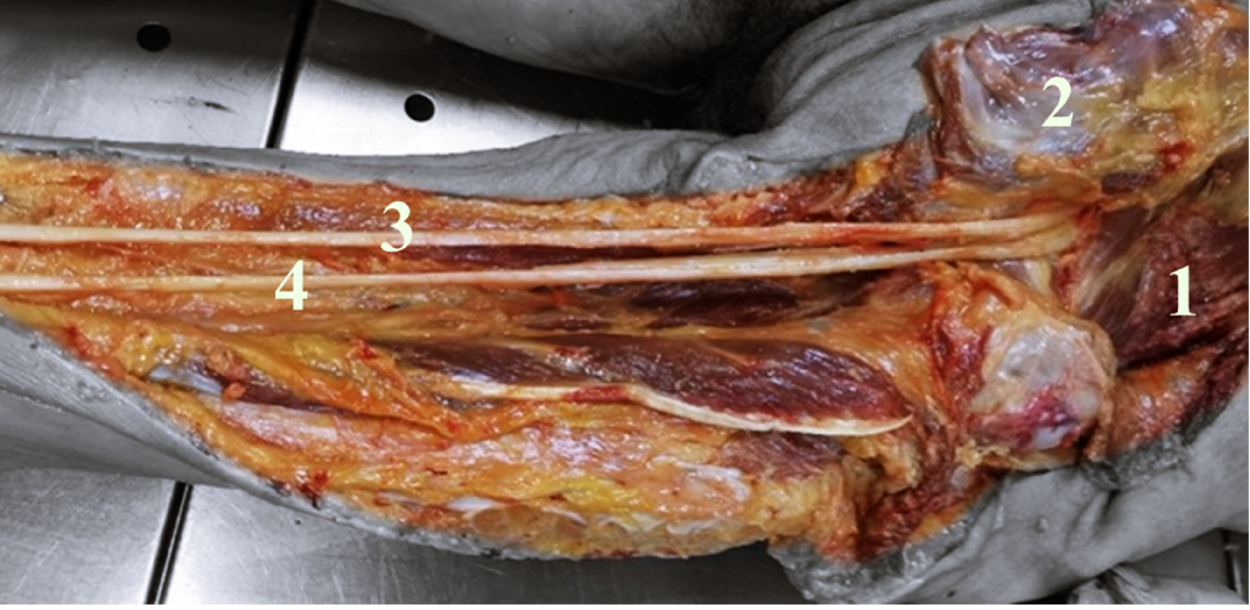
Figure 3. It shows a deep right gluteal region and right posterior femoral region. Gluteal major muscle retracted (1), PM (2). In this case, the SN divides into tibial nerve (3) and common peroneal nerve (4) in the gluteal region.